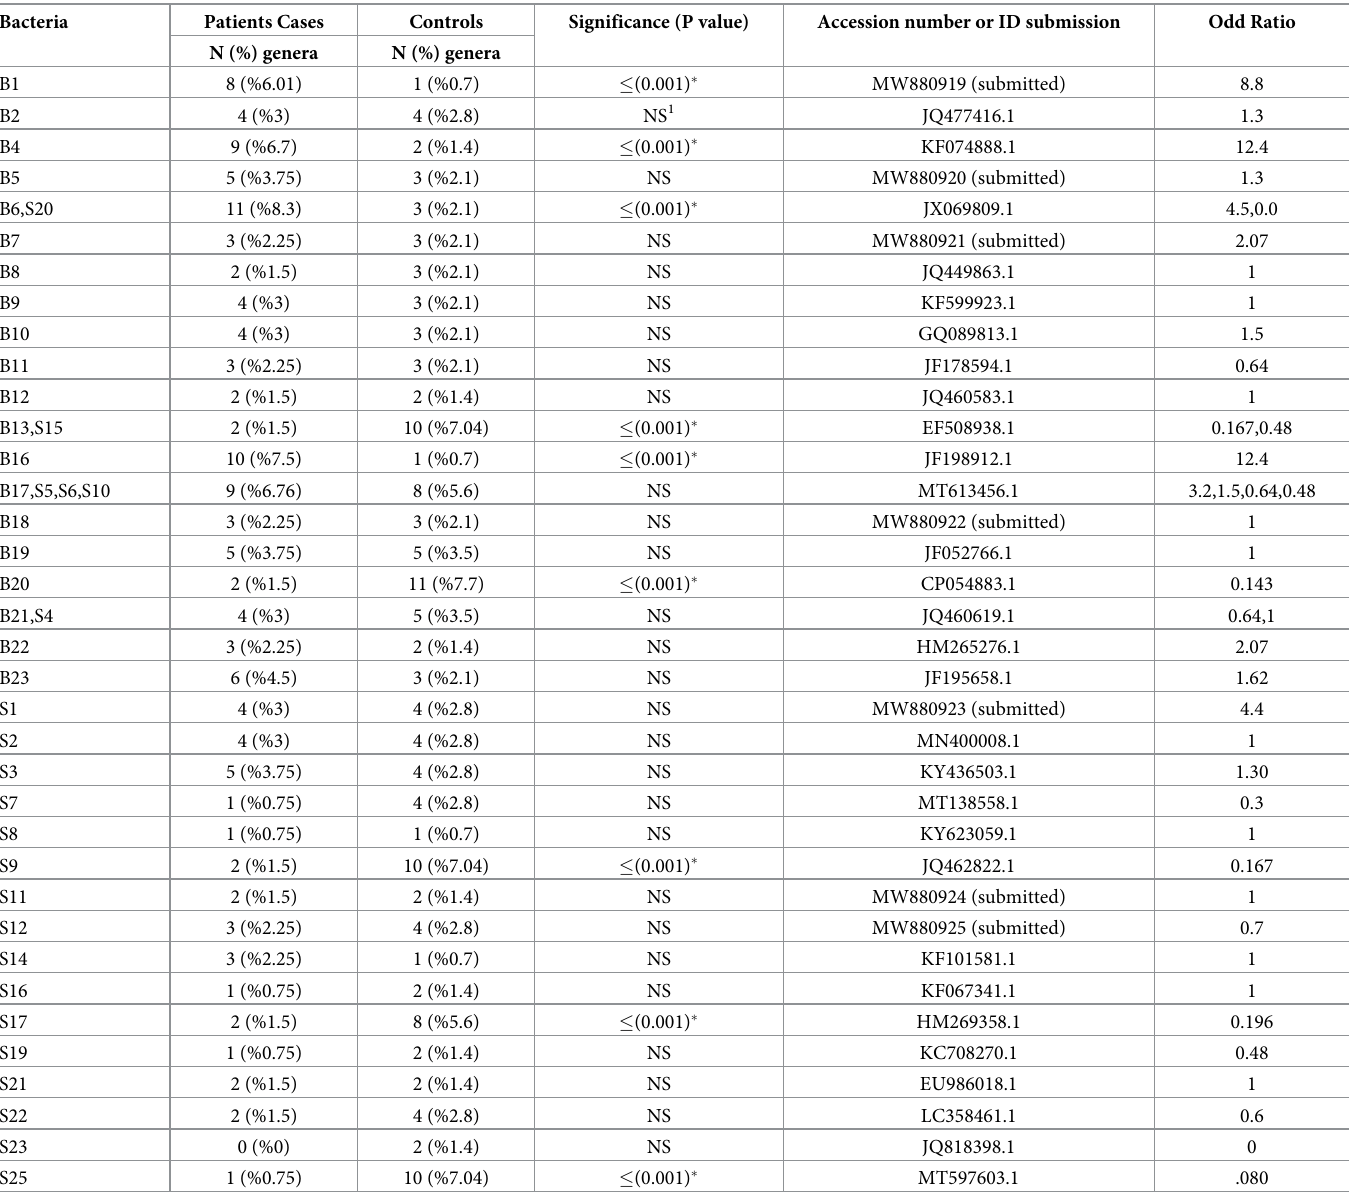
Table 4. Bacterial species isolated from polyacrylamide gel based on DGGE method. Bacteria Patients